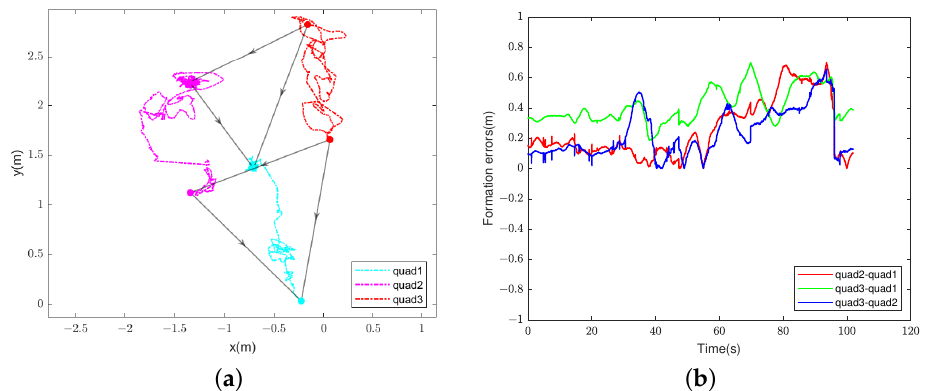
Figure 17. Formation trajectories and errors. ( a ) Trajectories of three quadrotors recorded by motion capture system. ( b ) Formation errors between each pair of quadrotors.